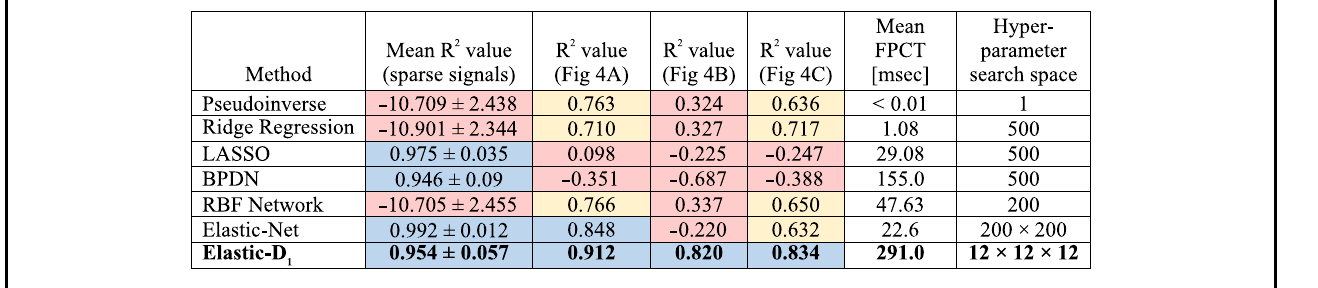
Average and standard deviation of R 2 -values for measurements of sparse spectra consisting of a single laser line at 11 different wavelengths evenly spaced on the range λ = [1555 nm, 1565 nm] and broadband spectra (black curves in Fig. 4). For each reconstruction technique, we include the average fi xed-parameter compute time (FPCT) required to solve the corresponding problem (shown in Table 1) and the dimensionality/size of the hyperparameter space used. Calculations were all performed on a laptop with an Intel Xeon E3-1505M v5 CPU and 16 GB of RAM. Blue shaded boxes correspond to R 2 values above 0.8, yellow is for R 2 between 0.6 and 0.8, and red is for R 2 less than 0.6. The results indicate that the elastic-D 1 algorithm consistently and accurately reconstructs both sparse and broadband input signals